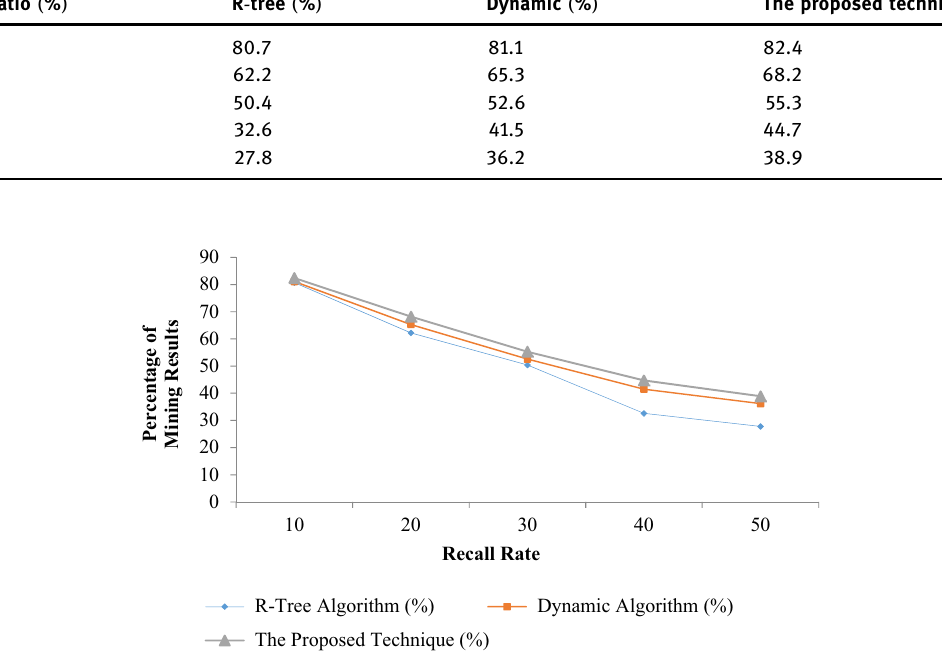
Table 5: Comparison of the proposed technique in terms of accuracy at the level of recall rate Recall ratio ( % ) R - tree ( % ) Dynamic ( % ) The proposed technique ( % )